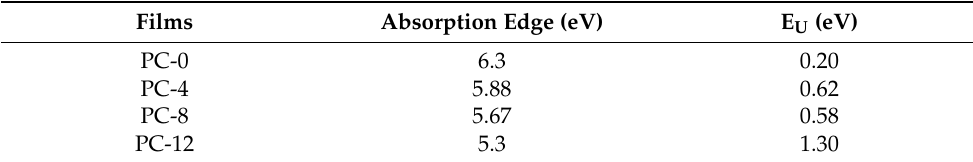
Figure 5. Absorption coefficients as a function of photon energy for all the polymer composite samples. Table 2. Extracted Urbach tail localized state and optical absorption edge; the magnitudes have approximately been determined from Figure 5.